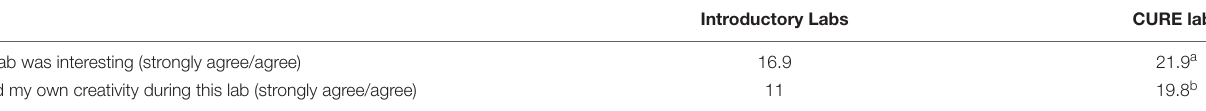
TABLE 5 | Assessment of student engagement.